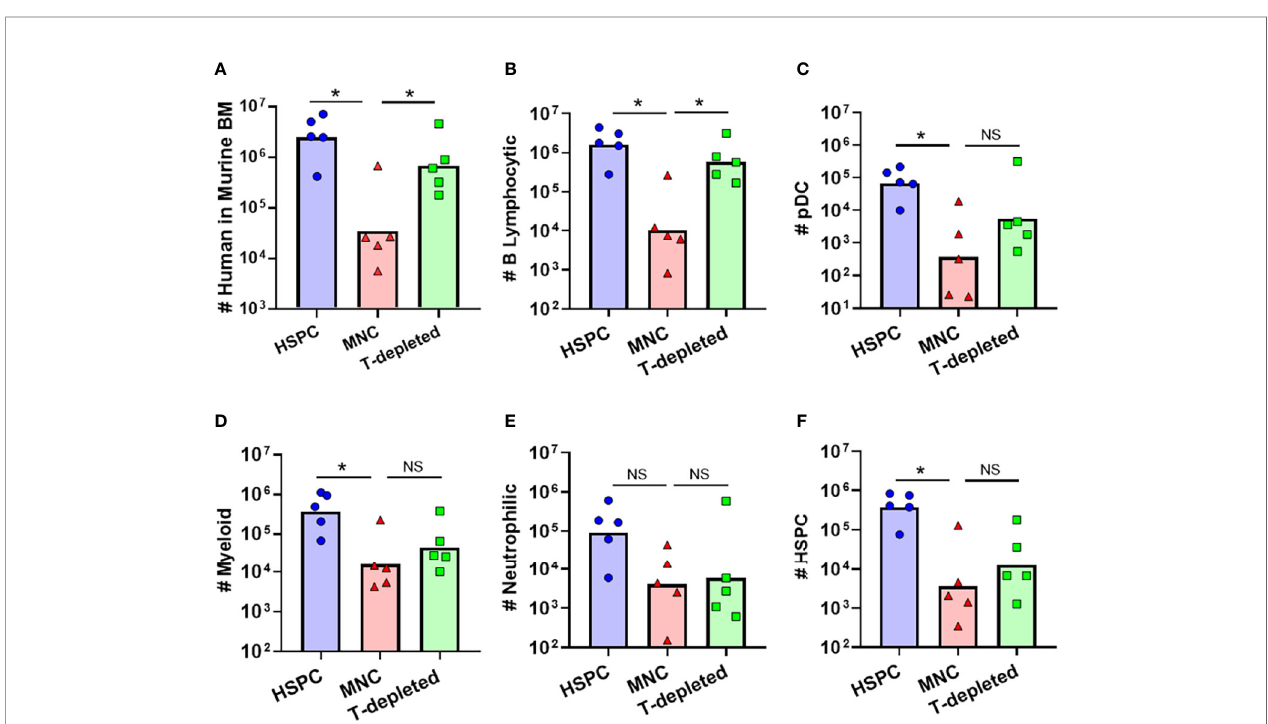
FIGURE 7 | Impact of other donor-derived cells on hematopoietic output. To determine how graft composition alters hematopoietic potential and lineage commitment, transplantation of isolated BM-HSPC (blue) was compared to total bone marrow mononuclear cells (MNC, red), or T cell-depleted MNC (green). For all conditions, the grafts contained 5E 5 HSPCs. (A) Plot showing total number of human cells in the bone marrow collected from one leg (femur + tibia) at 12 weeks post-transplantation. (B – F) Plots showing the total number of human cells of the indicated lineages for each graft condition. Symbols show results from individual mice, and bars show the geometric means. *p <